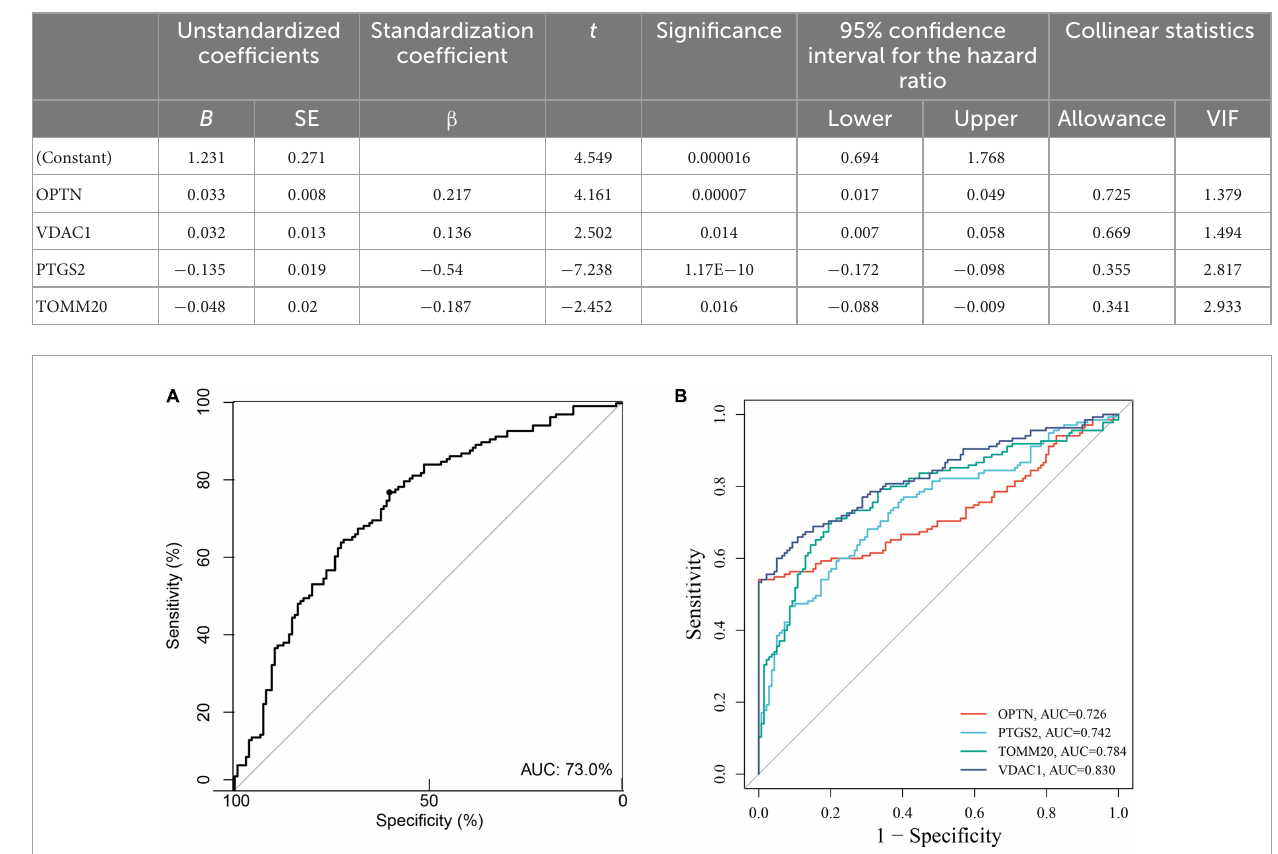
genes have potential as diagnostic and prognostic biomarkers for